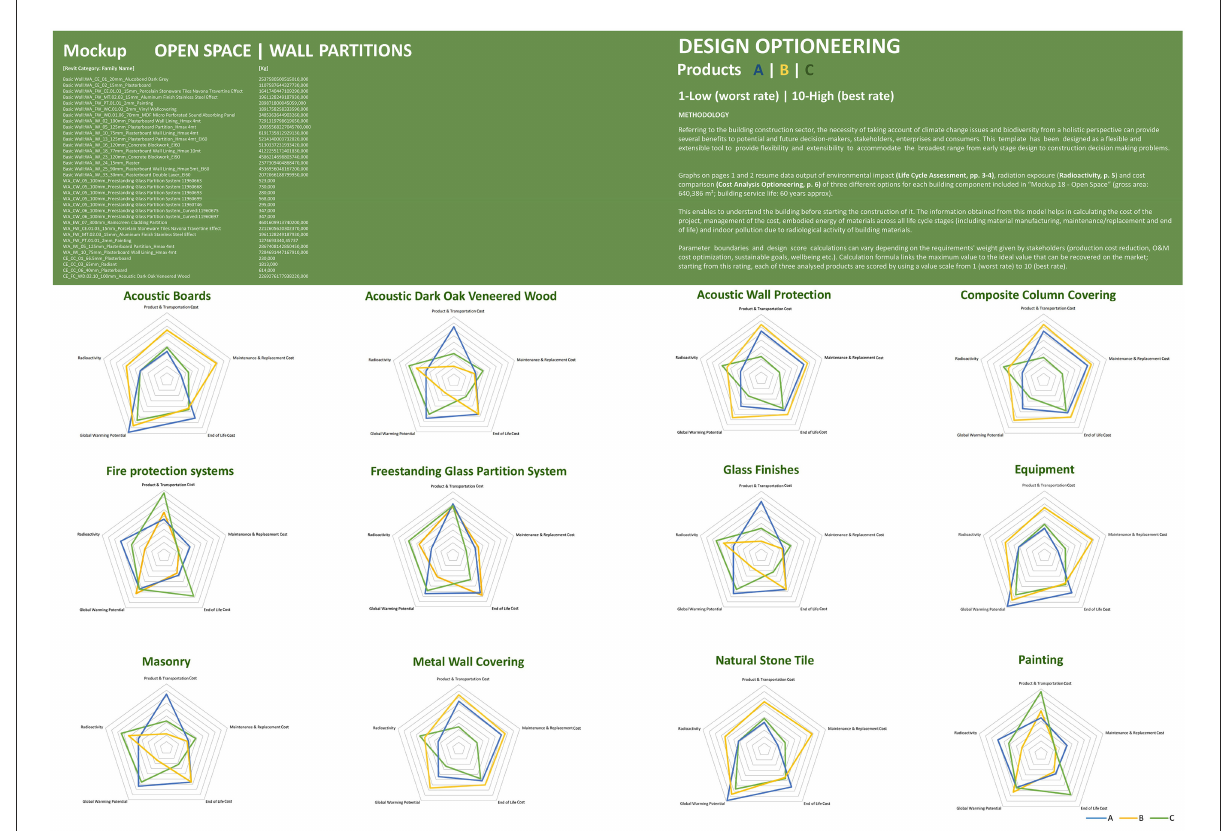
FIGURE8 Comparison between different product alternatives (A, B, C) for the elements used in the